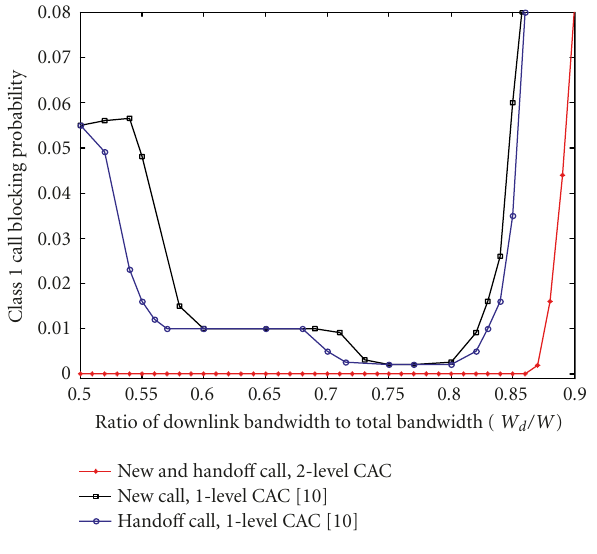
Figure 4: Call blocking probabilities versus aggregate new call ar- rival rate.